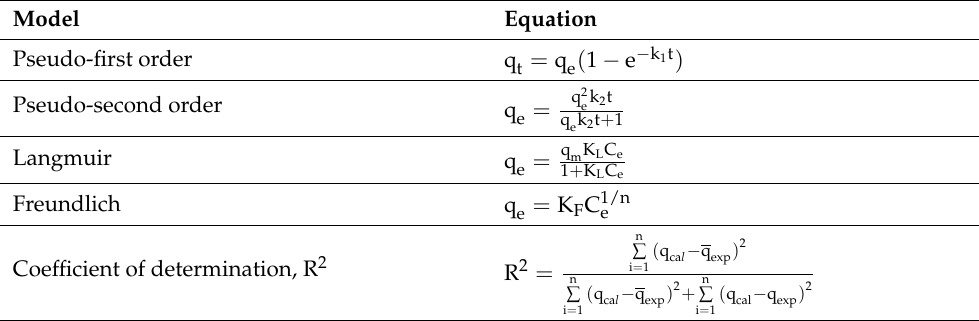
Table 1. Equation of adsorption kinetic, isotherm models, and fitting